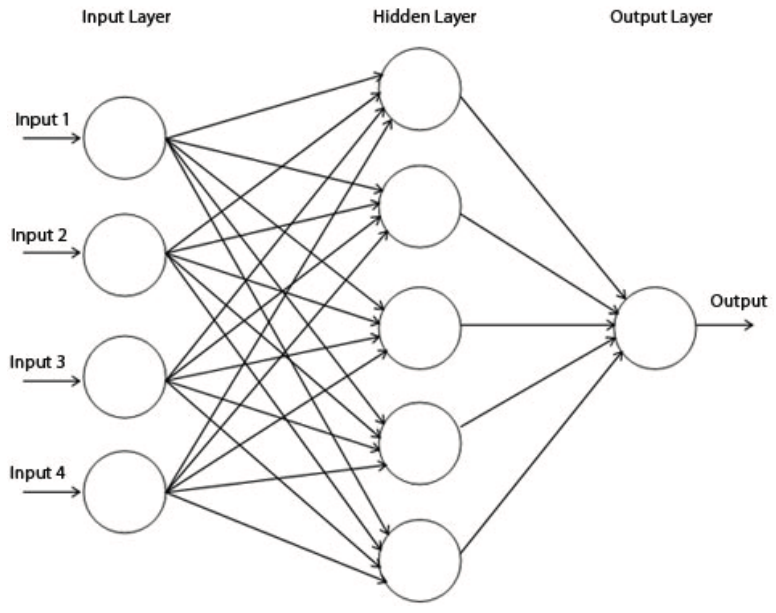
Figure 4. ANN schematization [58]. Input i is the input set, output is the result of network delay and each circle represents neural